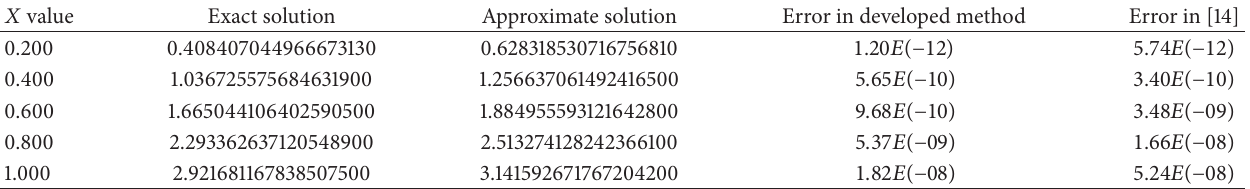
Table 5: Exact and approximate solutions for solving 𝑦 2 using the developed method.